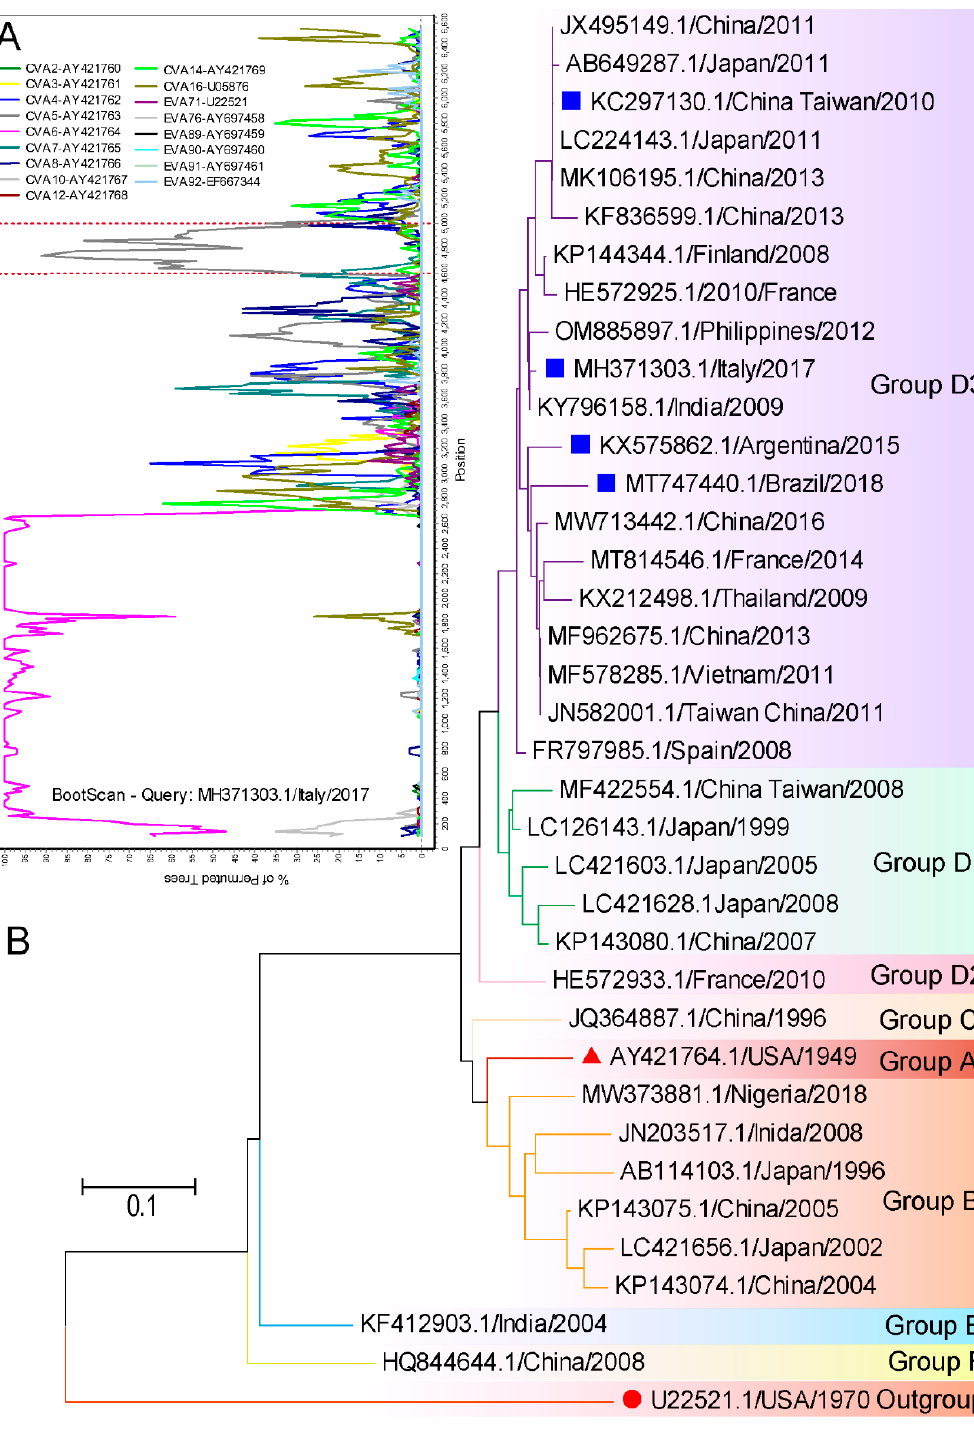
Figure 6. Evolutionary characteristics of CVA6 causing atypical HFMD available from GenBank were conducted applying MEGA 7 and Simplot 3.5.1 software. ( A ) The Bootscan analysis of MH371303.1/Italy/2017 based on the CDS region. The reference strains are represented in the legend. ( B ) Phylogenetic analyses of CVA6 based on a part of VP1 sequence (276 bp). The bootstrap test was performed with 1000 replications. All the strains are labelled using the following format: accession number/country of origin/year of isolation. The prototype strain of EVA71 marked with red circles indicates the outgroups. The prototype strain of CVA6 is marked as red triangles. The blue squares mark the representative strains causing atypical HFMD.